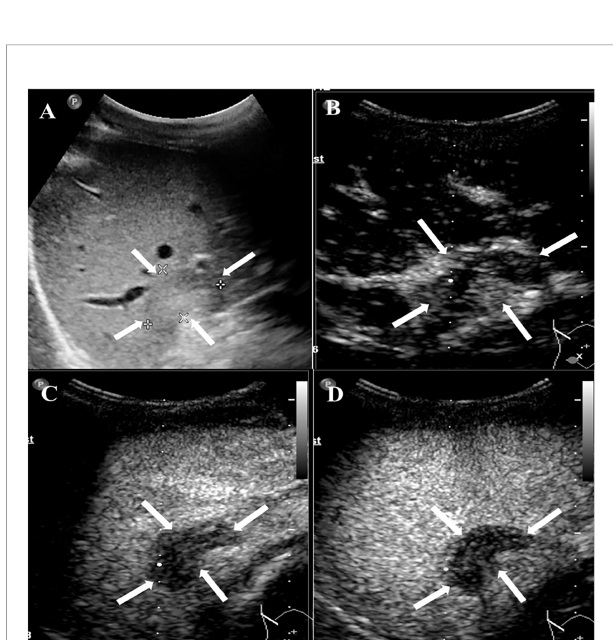
FIGURE 2 | CEUS features of HEHE in a 24-year-old male. (A) Greyscale ultrasound presented a subcapsular hypoechoic lesion (arrows) in the right hepatic lobe. (B) This lesion showed peripheral rim-like slight hyperenhancement (arrows) in the arterial phase (17 s). (C) The degree of enhancement washed out fast than the surrounding liver parenchymal and displayed hypoenhancement (arrows) in the portal phase (50 s). (D) In the late phase (135 s), the lesion remained hypoenhancement